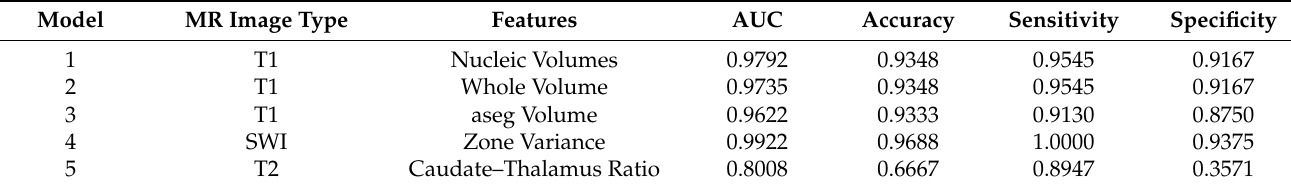
Table 4. The performance metrics of the trained random forest